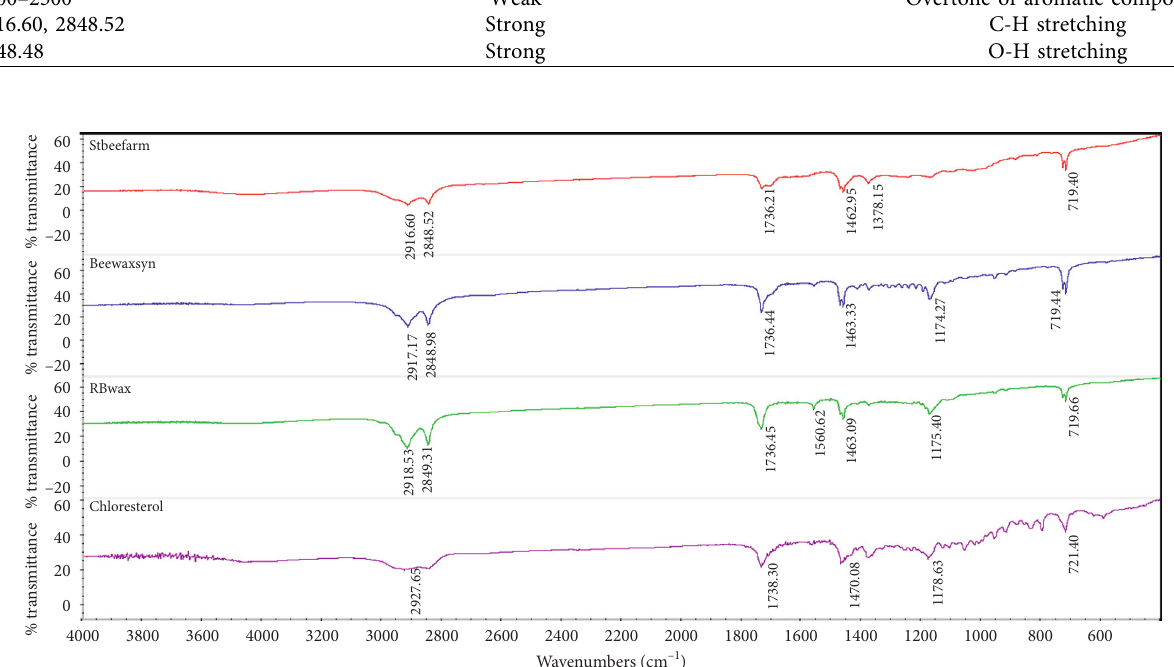
Figure 2: The FTIR spectra shows peaks of stingless bee wax (red), synthetic bee wax (blue), rice bran wax (green), and cholesterol